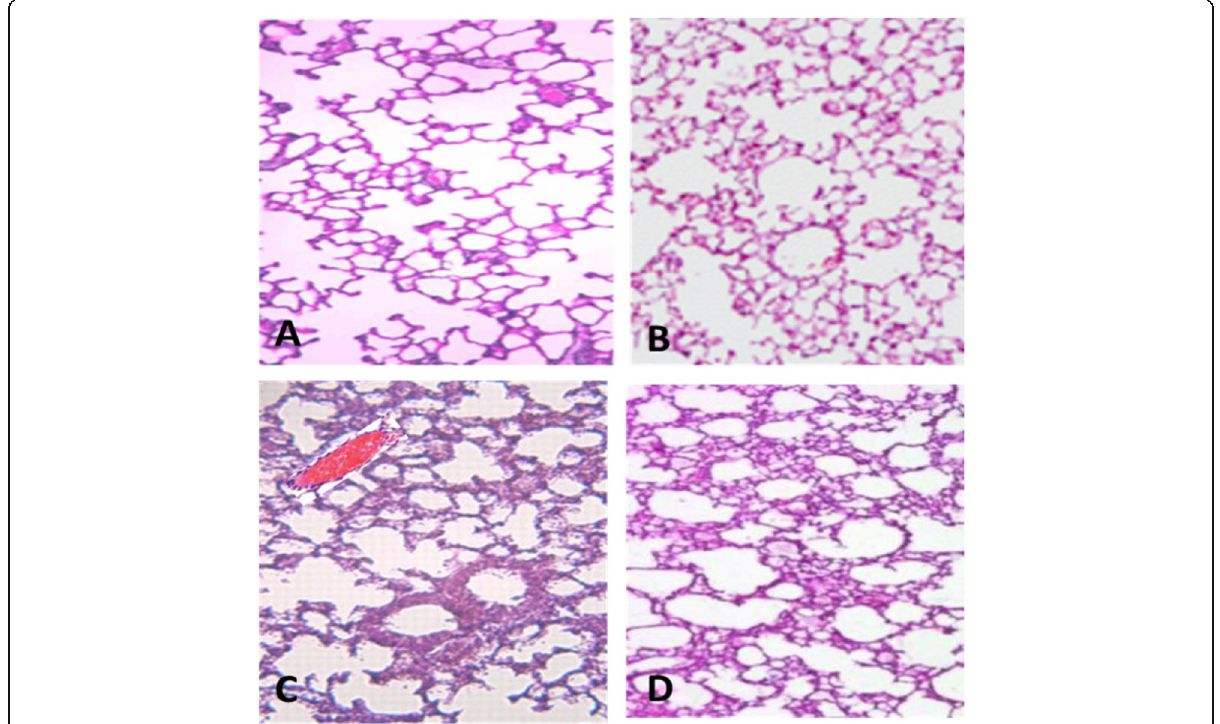
Fig. 3 Lung tissue of the control group (H&E X100) ( a ), a photomicrograph of lung section of control administered 100 mg/kg of alga H. clathratus (H&E X100) ( b ), a photomicrograph of lung section of rat given Cu (100 mg/kg) for 4 weeks (H&E X200) ( c ), and a photomicrograph of lung section of lung given Cu (100 mg/kg) in concomitant with algae for 4 weeks (HC) (H&E X200) ( d